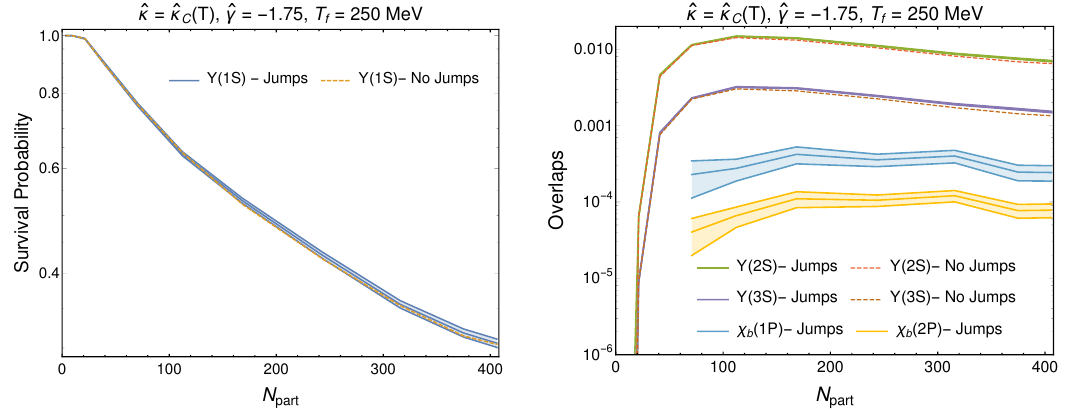
Figure 16 . Survival probabilities/overlaps versus N part with an Υ(1 S ) initial condition. The left panel shows the 1 S survival probability and the right panel shows the final overlaps of the excited states. The continuous lines are the full QTraj evolution including jumps and the dashed lines are the cases with no jumps; the bands indicate the statistical uncertainty of the full QTraj result which was obtained using 8192 quantum trajectories per point in N part